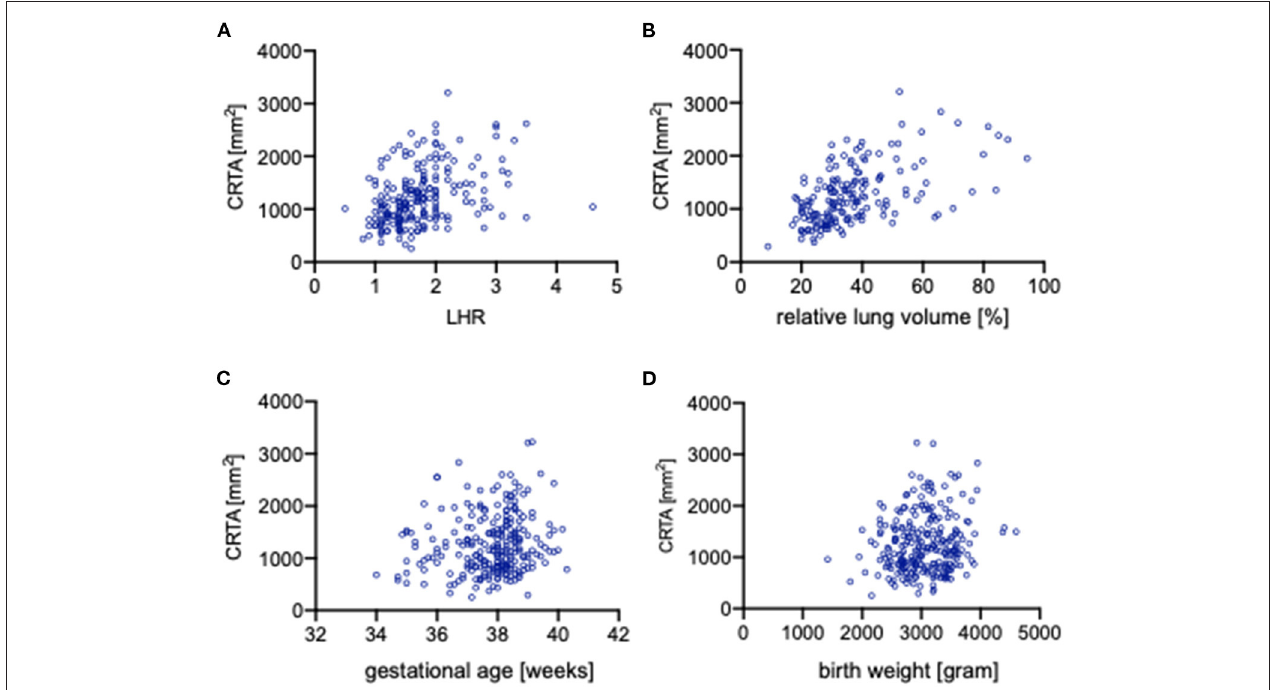
FIGURE 3 | Correlation of independent clinical parameters with CRTA. Scatterplots portraying the correlation of CRTA to (A) lung-to-head ratio ( r = 0.388, p < 0.0001), (B) relative lung volume ( r = 0.544, p < 0.0001), (C) gestational age ( r = 0.101, p = 0.107), and (D) birth weight ( r = 0.15, p = 0.017). CRTA, chest radiographic thoracic area; LHR, lung-to-head ratio.